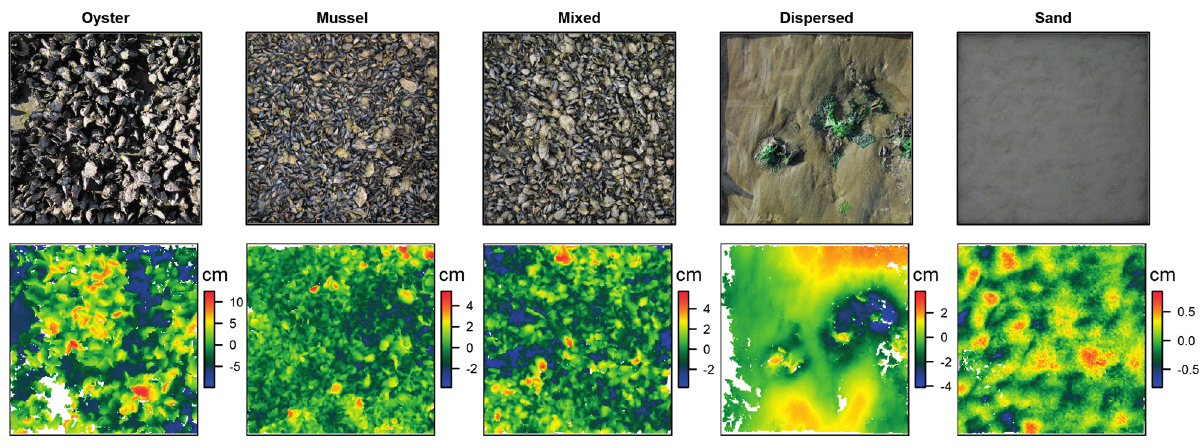
Figure 2. The top row shows examples of photos of the different substrate classes studied in the 1-m 2 plots. The bottom row shows corresponding examples of the measured height after rasterization of the point clouds at a resolution of 5